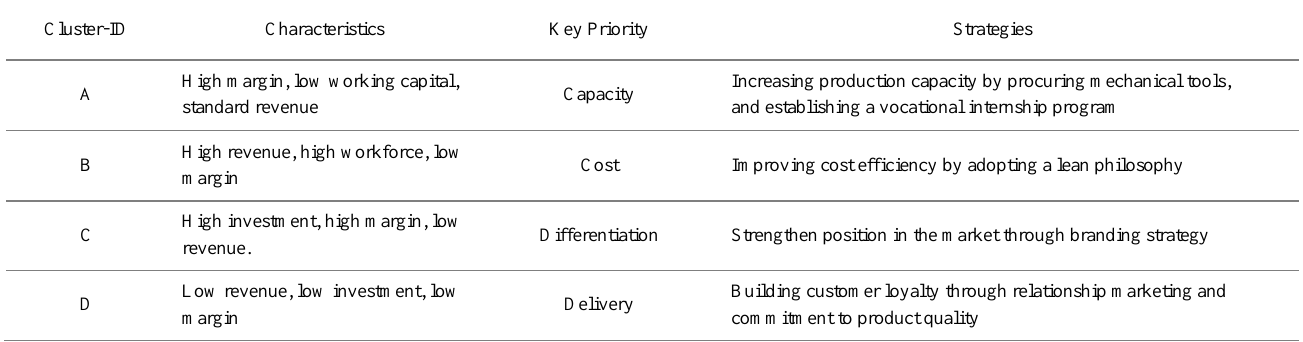
Table 4. Taxonomy of strategies for